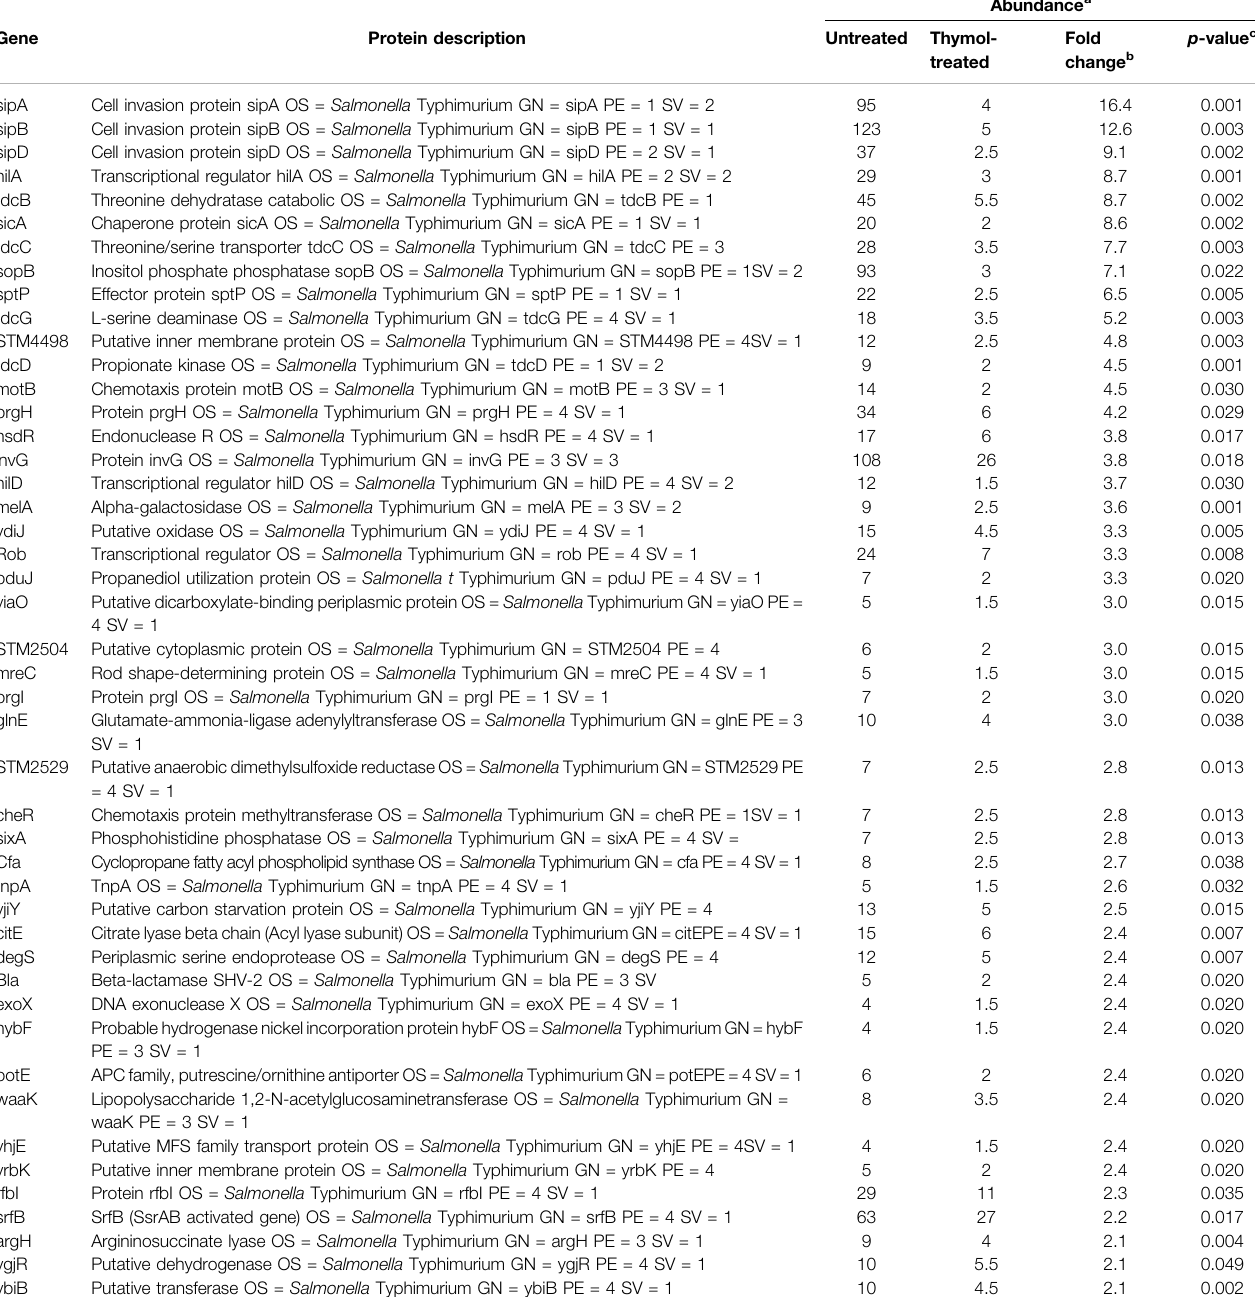
potE APCfamily,putrescine/ornithineantiporterOS (cid:2) Salmonella TyphimuriumGN (cid:2) potEPE (cid:2) 4SV (cid:2) 1 Lipopolysaccharide 1,2-N-acetylglucosaminetransferase OS (cid:2) Salmonella Typhimurium GN (cid:2) waaK PE (cid:2) 3 SV (cid:2) 1 yhjE Putative MFS family transport protein OS (cid:2) Salmonella Typhimurium GN (cid:2) yhjE PE (cid:2) 4SV (cid:2) 1 Putative inner membrane protein OS (cid:2) Salmonella Typhimurium GN (cid:2) yrbK PE (cid:2) 4 Protein rfbI OS (cid:2) Salmonella Typhimurium GN (cid:2) rfbI PE (cid:2) 4 SV (cid:2) 1 SrfB (SsrAB activated gene) OS (cid:2) Salmonella Typhimurium GN (cid:2) srfB PE (cid:2) 4 SV (cid:2) 1 Argininosuccinate lyase OS (cid:2) Salmonella Typhimurium GN (cid:2) argH PE (cid:2) 3 SV (cid:2) 1 Putative dehydrogenase OS (cid:2) Salmonella Typhimurium GN (cid:2) ygjR PE (cid:2) 4 SV (cid:2) 1 Putative transferase OS (cid:2) Salmonella Typhimurium GN (cid:2) ybiB PE (cid:2) 4 SV (cid:2) 1 a Averaged spectral counts from three biological replicates. b Fold change in protein abundance; positive or negative values indicate higher or lower levels in the thymol-treated samples comparing to untreated cells. c p-values were calculated using paired Student ’ s t